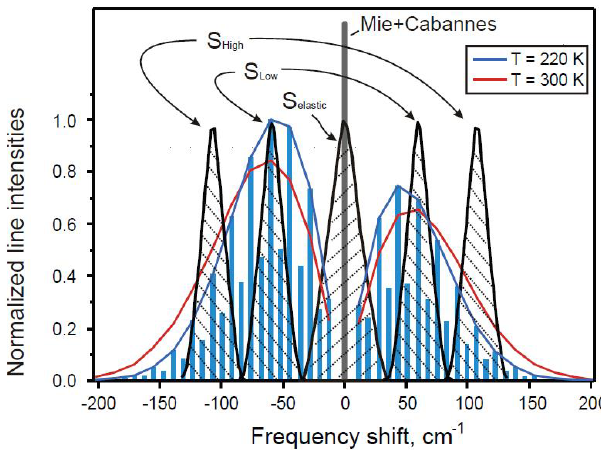
Figure 4. Temperature dependence of the Stokes and anti-Stokes pure rotational Raman spectrum of N 2 calculated at 220 and 300K. The intensity of the spectral lines are in normalized relative units. The frequency shift on the x axis refers to a laser’s wavelength of 355nm. The total intensity of the high and low quantum-shifted PRR channels is the summation of the single line intensities under- neath the bell-shaped black